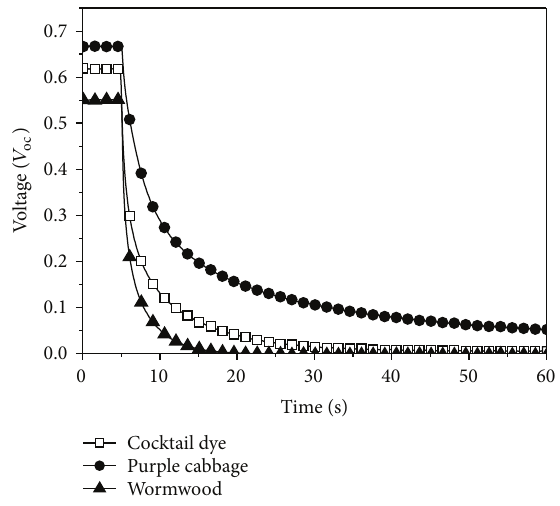
Figure 8: Open-circuit voltage decay of DSSCs sensitized by chlorophyll, anthocyanin, and cocktail dye.